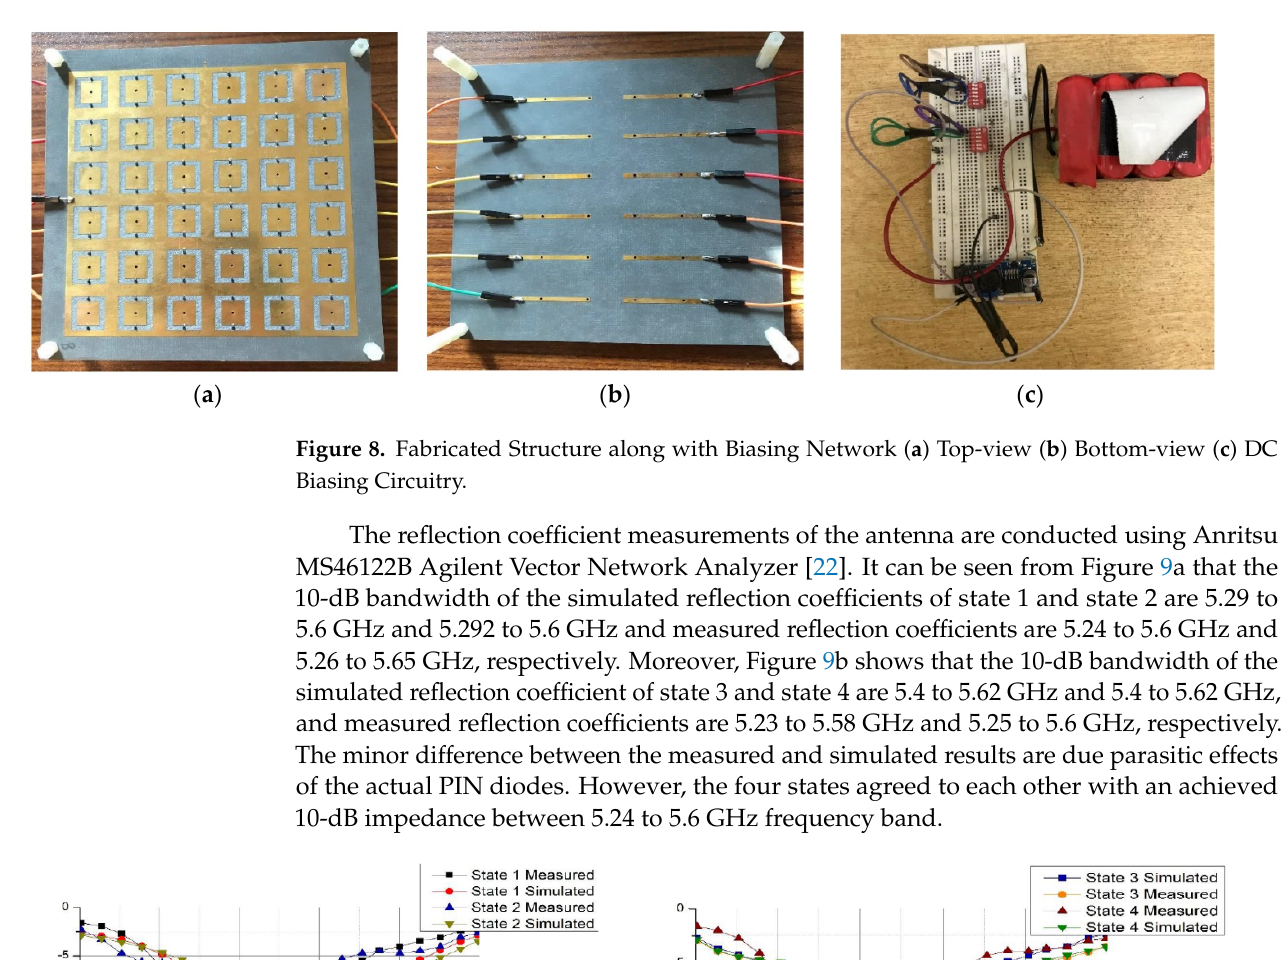
Figure 9. Reflection coefficient results of the proposed structure ( a ) States 1 and 2 ( b ) States 3 and 4.